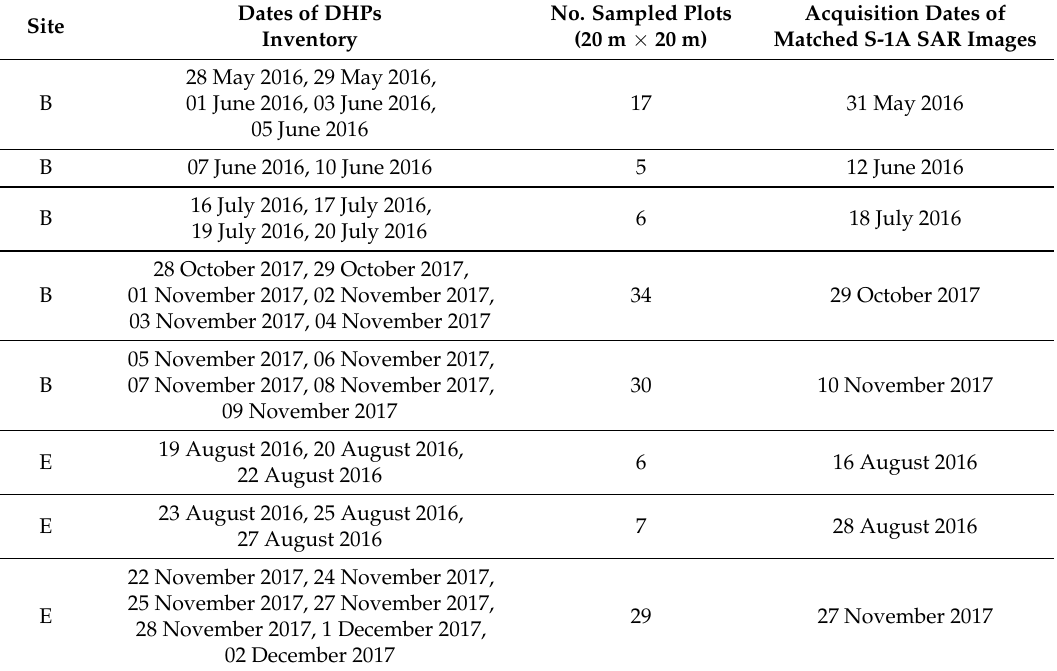
Figure 2. Protocol of canopy gap fraction estimation from DHPs: ( a ) DSLR camera and fisheye lens setup in sample point. ( b ) DHP processing chain. Table 1. DHP inventory dates, the number of sampled plots (cocoa agroforestry systems (CAFS) and transition forests), and used Sentinel-1A (S-1A) synthetic aperture radar (SAR) images to test correlation with canopy cover. B: Bokito site, E: Efoulan site.